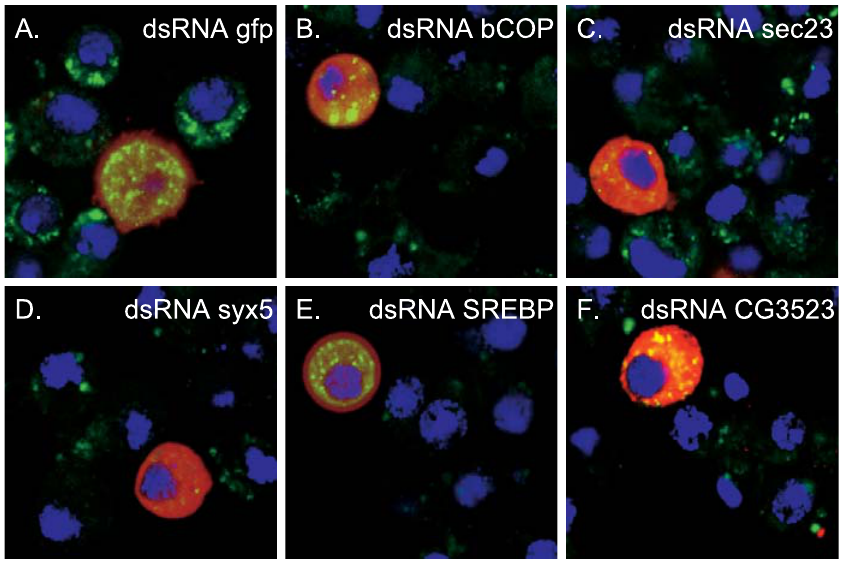
Figure 4. COPI-Dependent Golgi Disassembly in DCV Infected Cells Confocal analysis of cells pretreated with the indicated dsRNA and infected with DCV. (A) Golgi morphology of DCV-infected control cells (GFP) reveals that the normal punctate staining in uninfected cells is dispersed during viral replication. (B–F) Loss of COPI (bCOP) (B), SREBP (E), or CG3523 (F) but not COPII (sec23) (C) or Syx5 (D) results in a decrease in viral infection. Note that the Golgi stain is reduced in uninfected COPI, COPII, SREBP, CG2523, and Syx5, but only the loss in COPI, SREBP, or CG3523 results in a decrease in DCV replication. Green, anti-Golgi (DG13); red, anti-DCV; blue, Hoescht 33342. DOI: